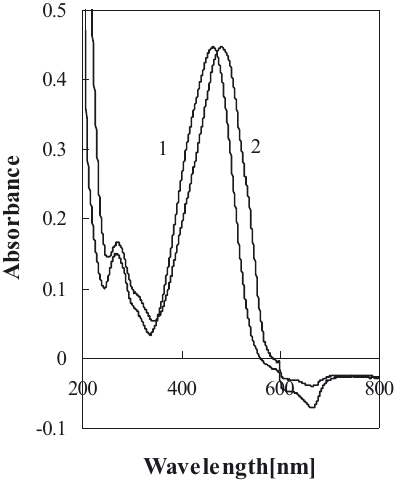
Figure 1. UV-vis spectrum of MO (1) initial MO (2)MO+K